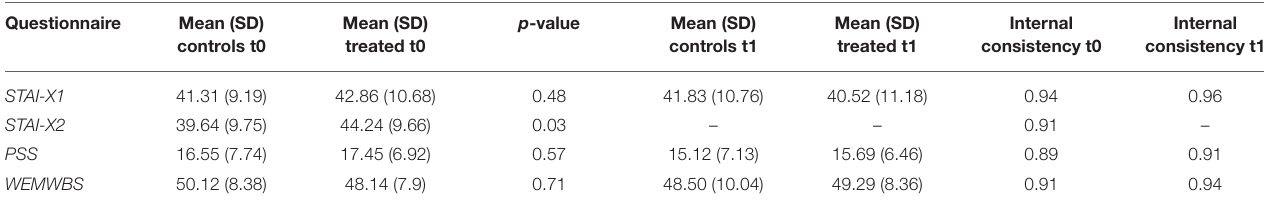
P-values of the baseline differences between group is also reported. SD, Standard Deviation; –:questionnaire collected at t 0